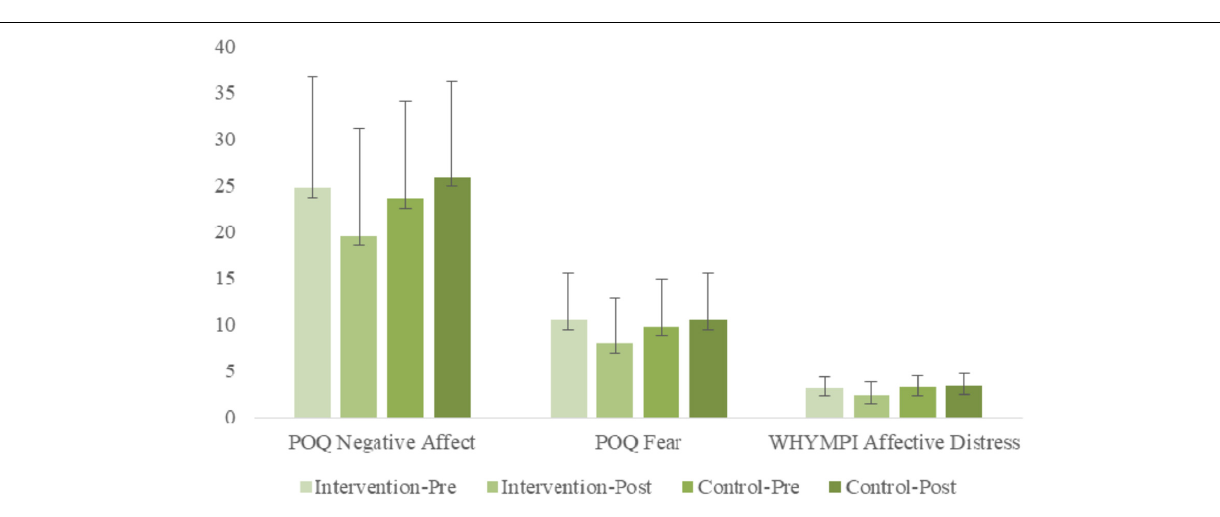
FIGURE 4 | Pre- and post-treatment comparisons of treatment and control groups on negative affect variables: POQ Negative Affect; POQ Fear; WHYMPI Affective